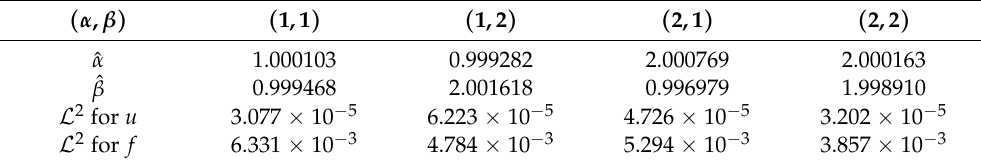
Table 3. Partial integro-differential equation: estimated values of ( α , β ) and the relative error L 2 for u ( t , x ) and f ( t , x ) , where N u = 20, N f = 20, ( α , β ) is fixed to be (1, 1), (1, 2), (2, 1) and (2, 2), in turn. ( α , β )